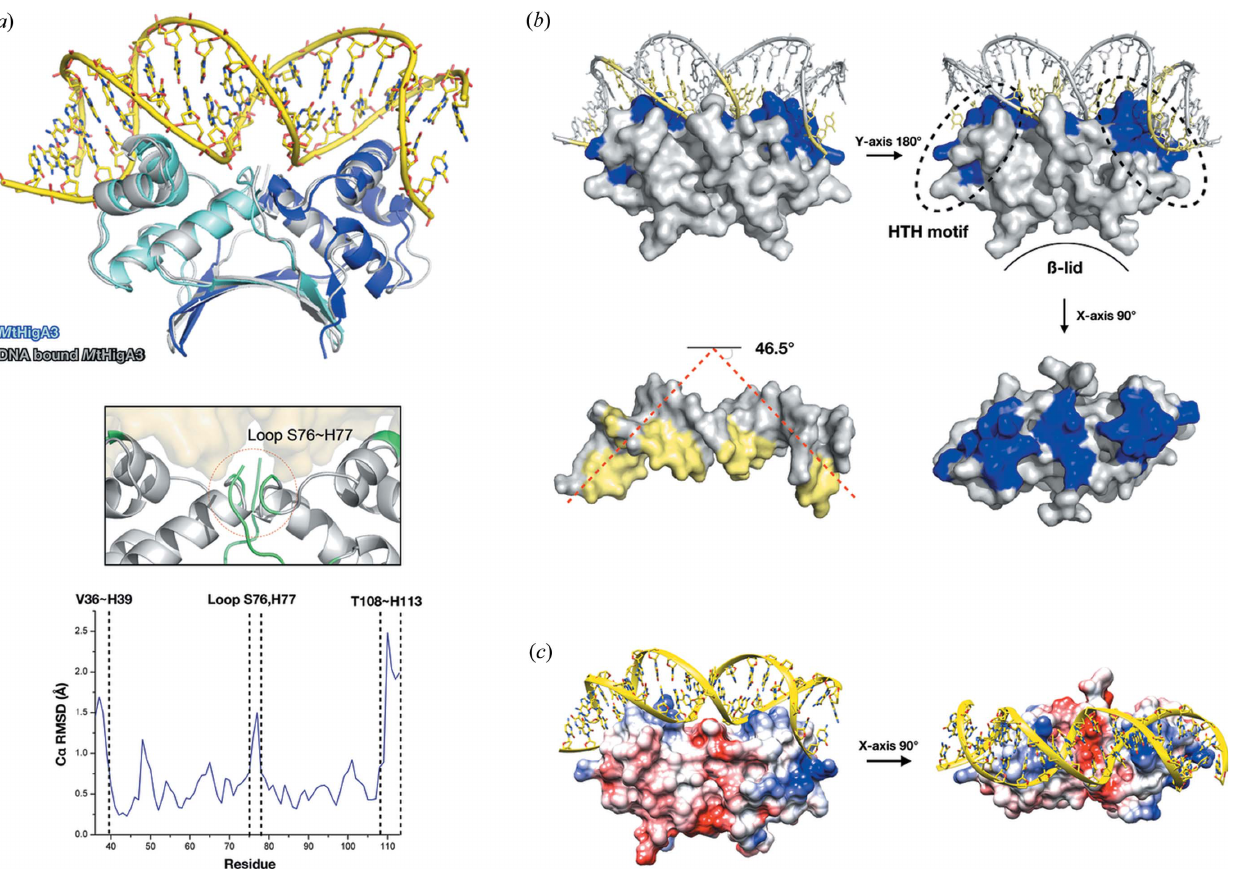
Figure 4 Overall structure of Mt HigA3 bound to DNA. ( a ) Superimposed cartoon representation of Mt HigA3 bound to DNA and the Mt HigA3 dimer structure (produced by matching the Mt HigA3 dimer of both models). The Mt HigA3 dimer is coloured cyan and blue. Mt HigA3 bound to DNA is coloured grey. The DNA fragment of Mt HigA3 bound to DNA is coloured yellow. Plot of C (cid:3) r.m.s.d. of the Mt HigA3 dimer and Mt HigA3 bound to DNA to compare C (cid:3) movement after DNA binding. N-terminal (Val36–His39), loop region (Ser76–His77) and C-terminal (Thr108–His113) residues show relatively large deviations. The region showing more than 1 A˚ r.m.s.d. is drawn in the black box and highlighted in green. ( b ) Cartoon and surface representation of Mt HigA3 bound to the DNA structure in diverse orientations. The regions of Mt HigA3 and DNA structure, which involve contact with each other, are coloured blue ( Mt HigA3) and yellow (DNA). Bent DNA in Mt HigA3 bound to the DNA structure is marked as a red line. Promoter DNA is dramatically bent by the binding of Mt HigA3 (46.5 (cid:2) ). ( c ) Superimposed Mt HigA3 dimer and DNA structure of Mt HigA3 bound to DNA. The electrostatic surface potential of the Mt HigA3 dimer is coloured between (cid:4) 10 kTe (cid:4) 1 (red) and 10 kTe (cid:4) 1 (blue) in two orientations rotated by 90 (cid:2) . The DNA structure of Mt HigA3 bound to DNA is presented as a cartoon representation. DNA binds to the positively charged region of the Mt HigA3